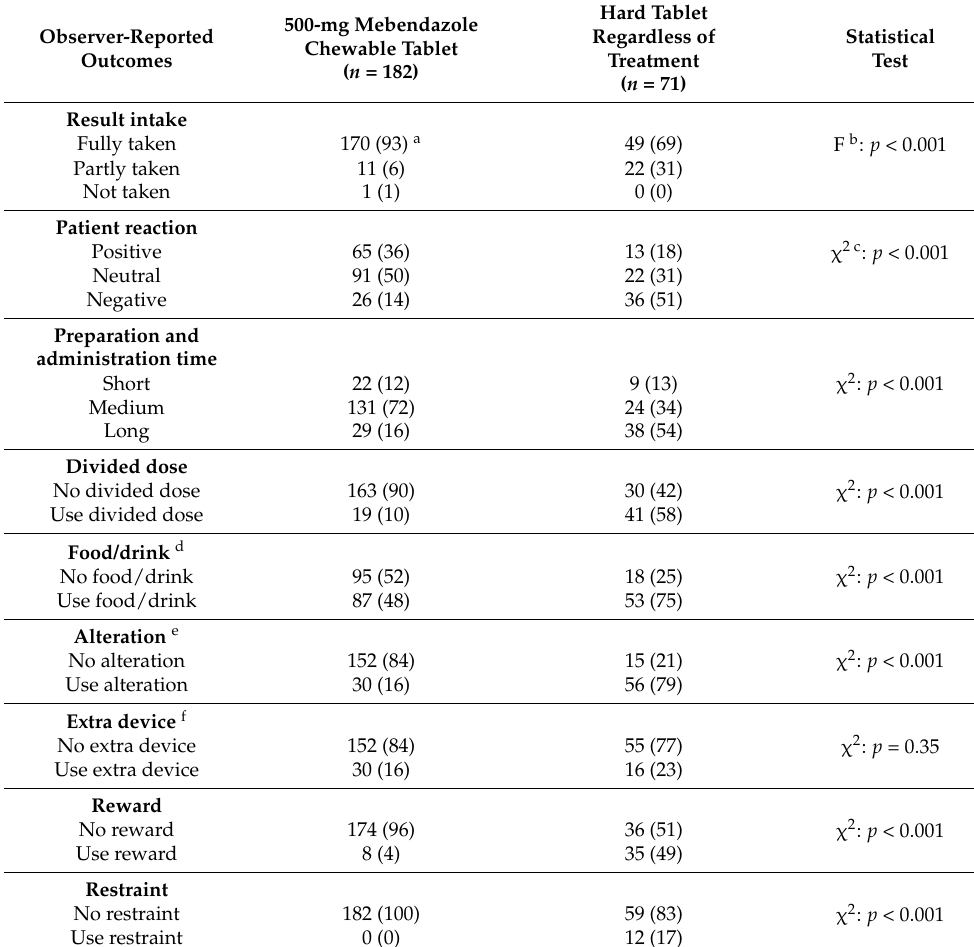
Table 2. Observer-reported outcomes for 500-mg mebendazole chewable tablet compared with tablets regardless of treatment in children aged 2 to 4